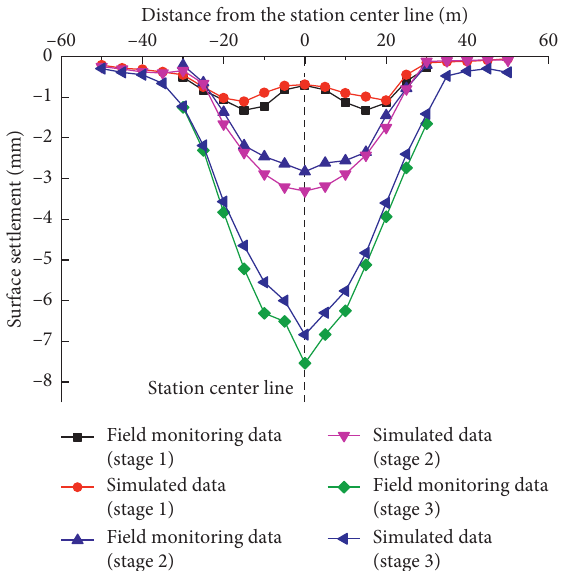
Figure 11: The data curve of surface